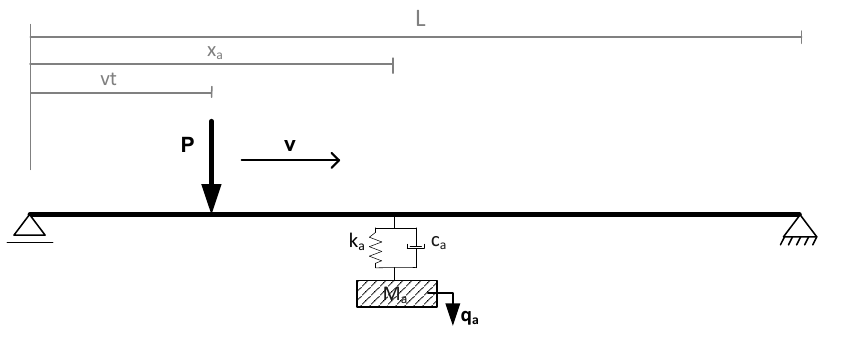
Figure 1: The model of the